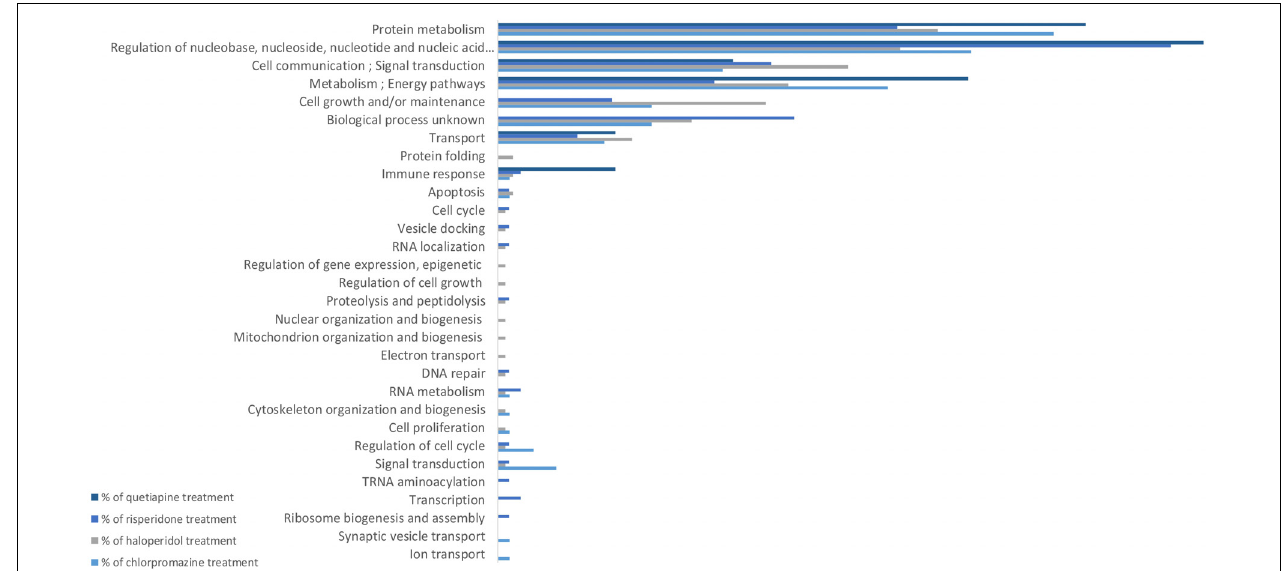
FIGURE 1 | GO biological processes affected by antipsychotic treatment in MO3.13 cell